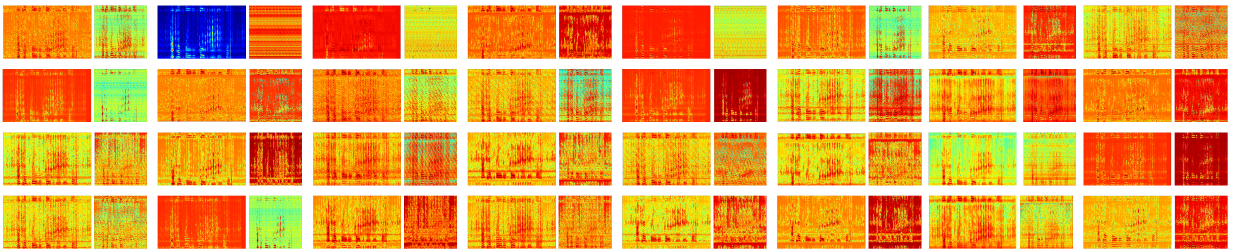
Figure 11. The spectrograms of 32 randomly selected convolution filters (wider spectrogram) and ReLU activation outputs from the second and third hidden layers of the CNN architecture b , for a processed noisy speech (N) and its clean version (C), f represents convolution filters, a represents activations.